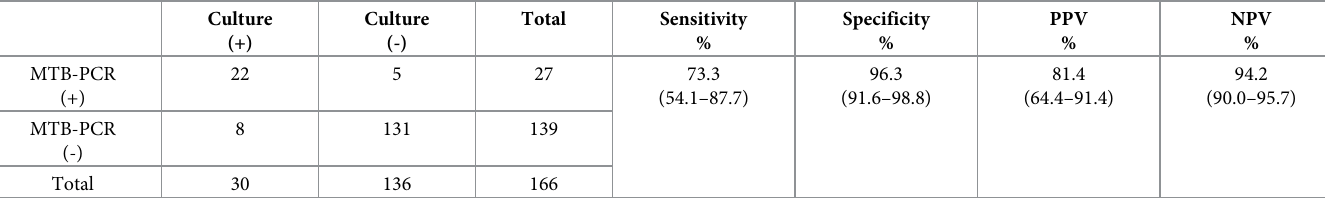
Table 2. Diagnostic yield of MTB-PCR using bronchoscopy samples considering AFB culture as the gold